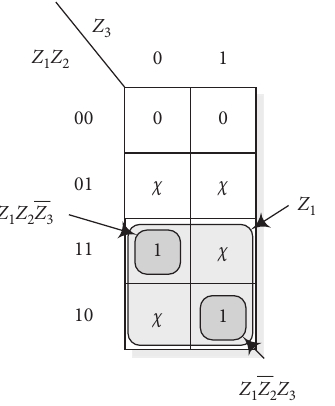
Figure 7: Example of the use of “do not care” conditions to simplify an expression. Without “do not care” Y With “do not care” Y “do not care” terms to get the simplest